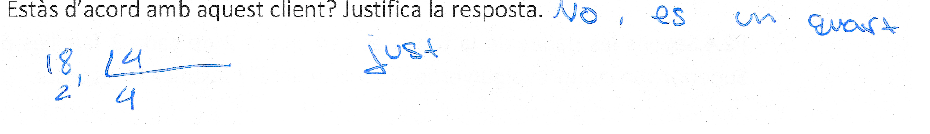
Figure 11. Partially correct answer of Q5. Student does not use decimals (translation: no, it is a quarter).